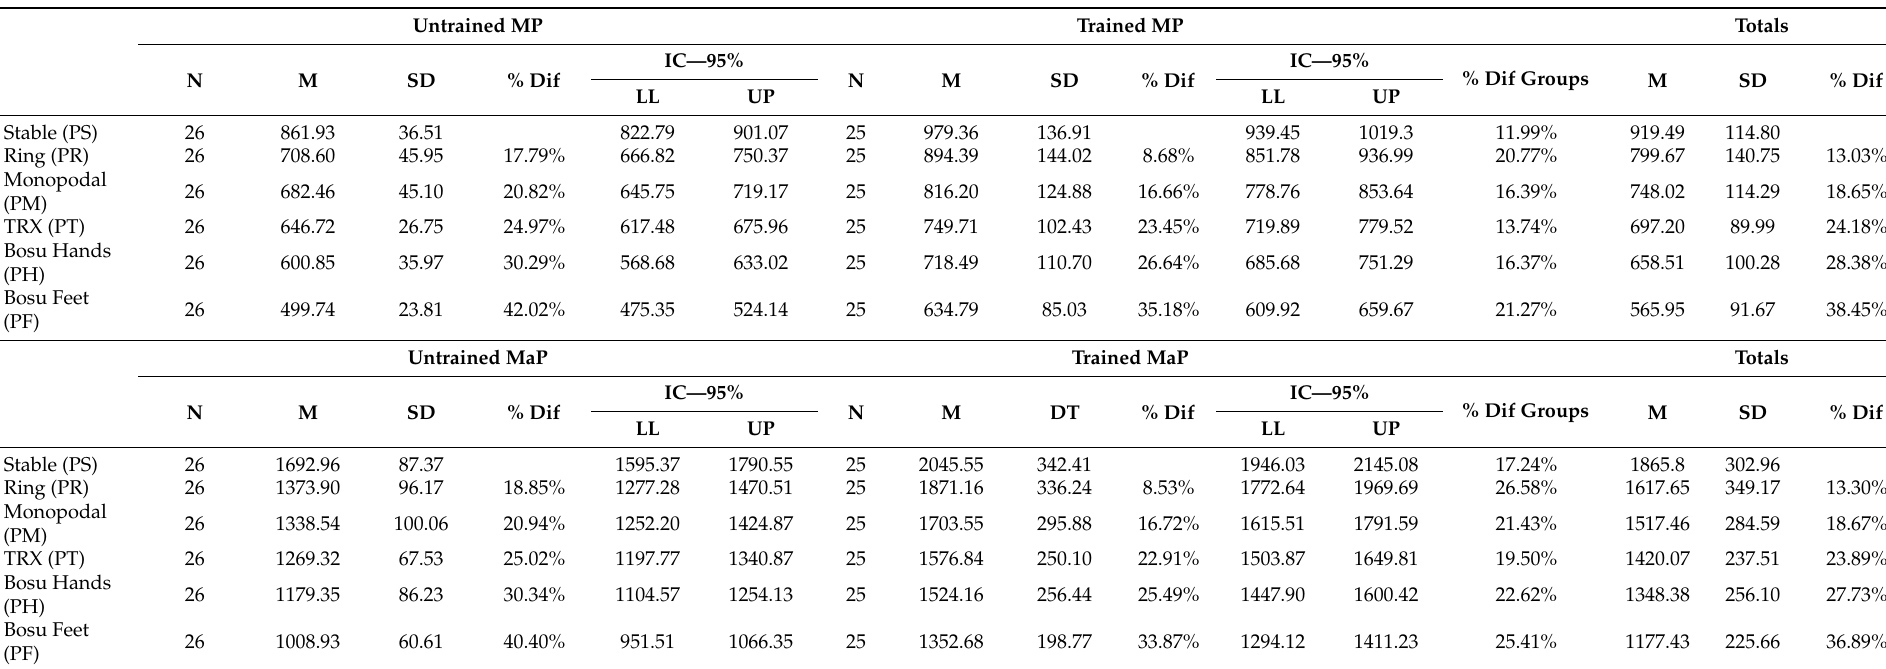
Table 2. Descriptive statistics for mean power (MP) and maximum power (MaP) measured in watts (W) as a function of instability. Untrained